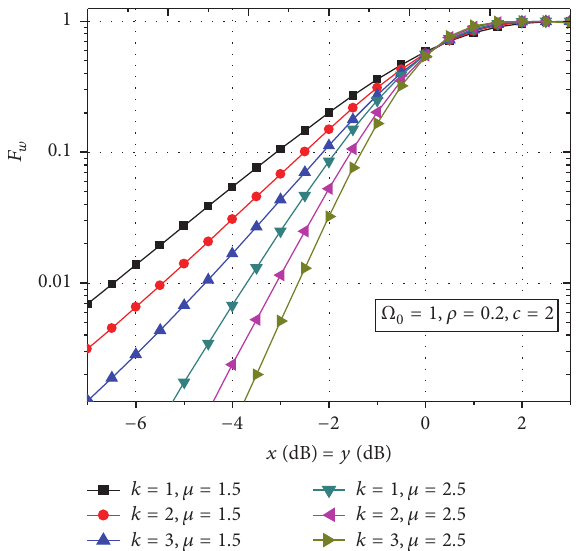
Figure 3: Cumulative distribution function of macrodiversity SC receiver.